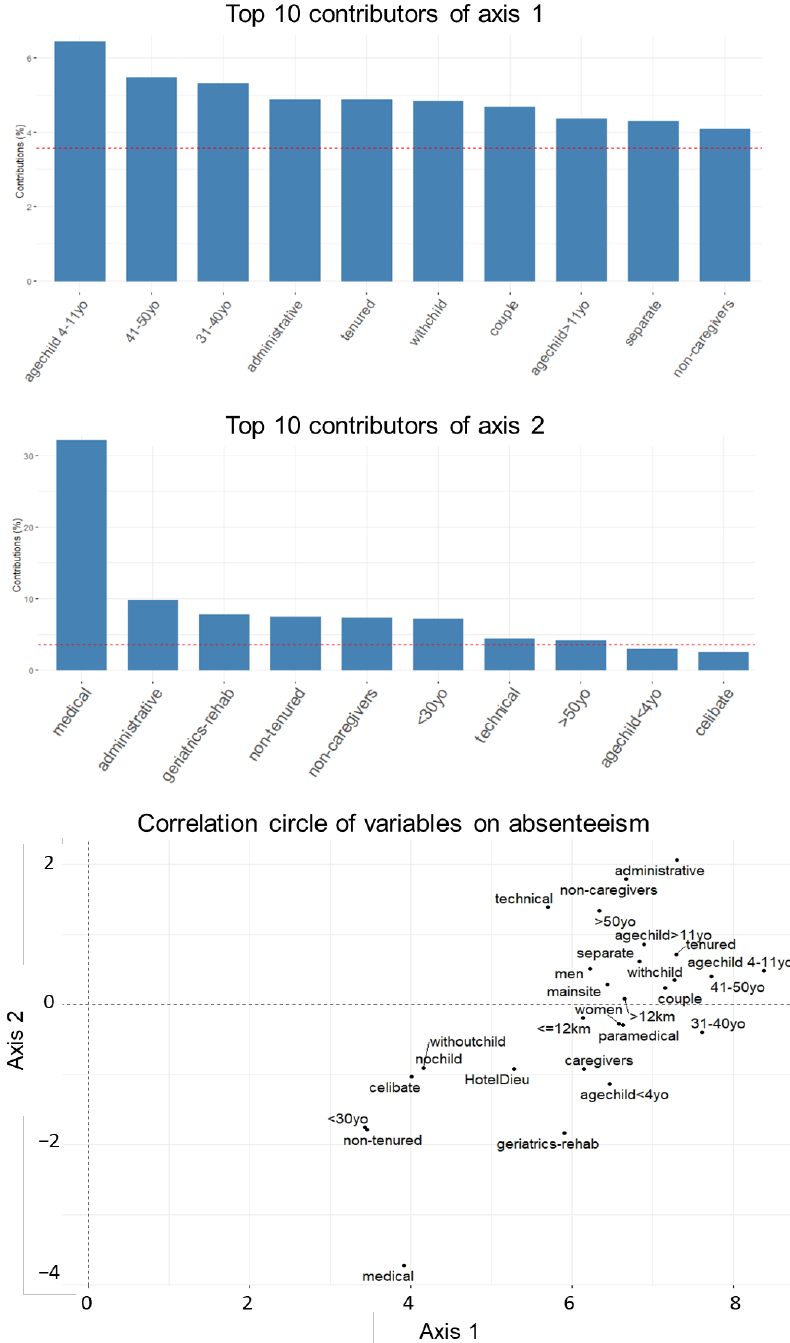
Figure 4. Largest contributors to the most absent (axis 1) and least absent (axis 2) profiles.